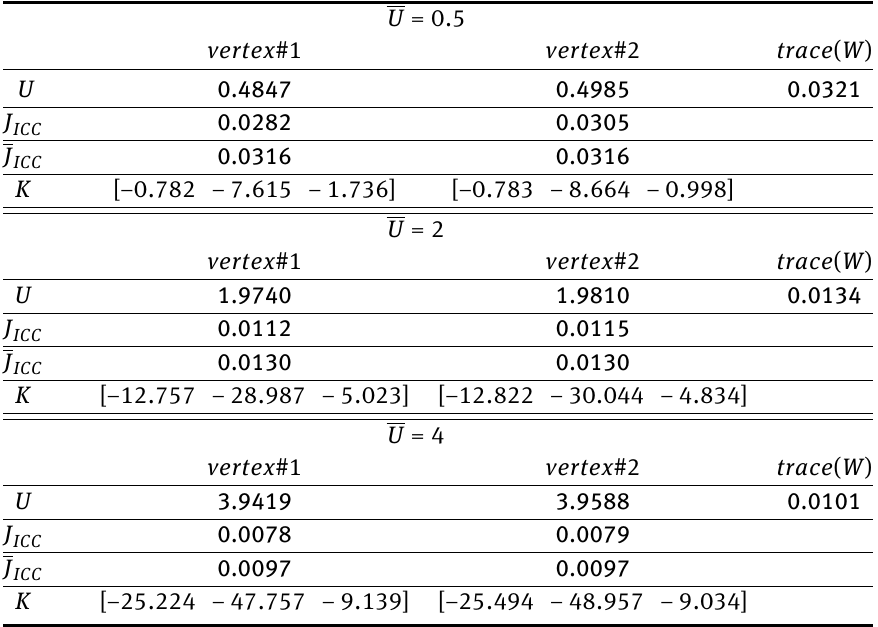
Table 3: ICC cost and Control covariance at the system vertices for Example 2 ( ϵ = 0.05 ).